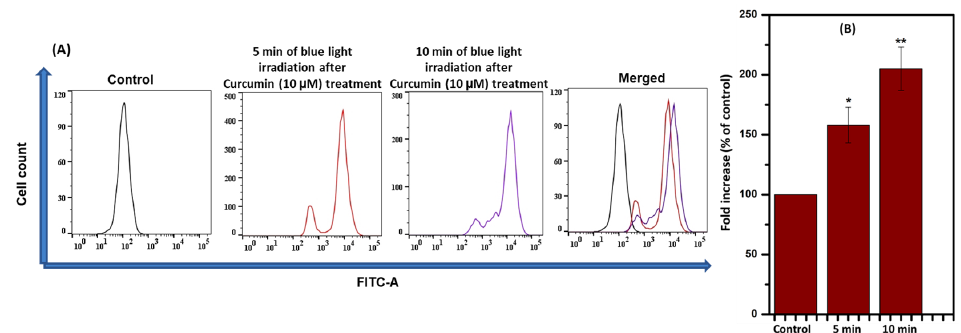
Figure 4. ( A ) Measurement of iROS in the presence and absence of blue light (with and without Curcumin) and ( B ) a merged image of the same. ( B ) The quantitative analysis of oxidized DCFDA levels and statistical analysis after 5 and 10 min of blue-light-irradiated 10 µM Curcumin-treated cells where: * denoted control versus 5 min of irradiation after Curcumin treatment (10 µM) and ** denoted control versus 10 min of irradiation after Curcumin treatment (10 µM). The significant results presented a p value < 0.05.